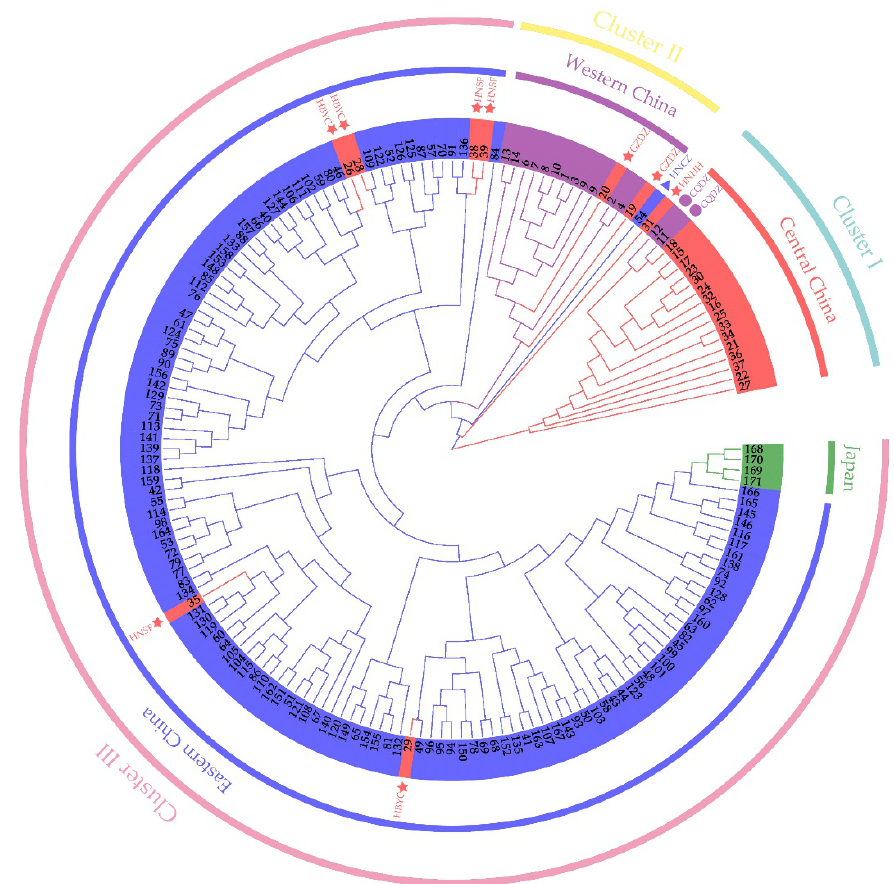
Figure 2. Neighbour-joining phylogenetic tree of C. camphora based on all single nucleotide poly- morphisms (SNPs), with the evolutionary distances measured by p-distances with TreeBest. The populations from different geographic locations were coloured red (Central China), purple (Western China), blue (Eastern China), and green (Japan). ★ , Individuals in Central China; ● , Individuals in Western China; ▲ , Individuals in Eastern China.